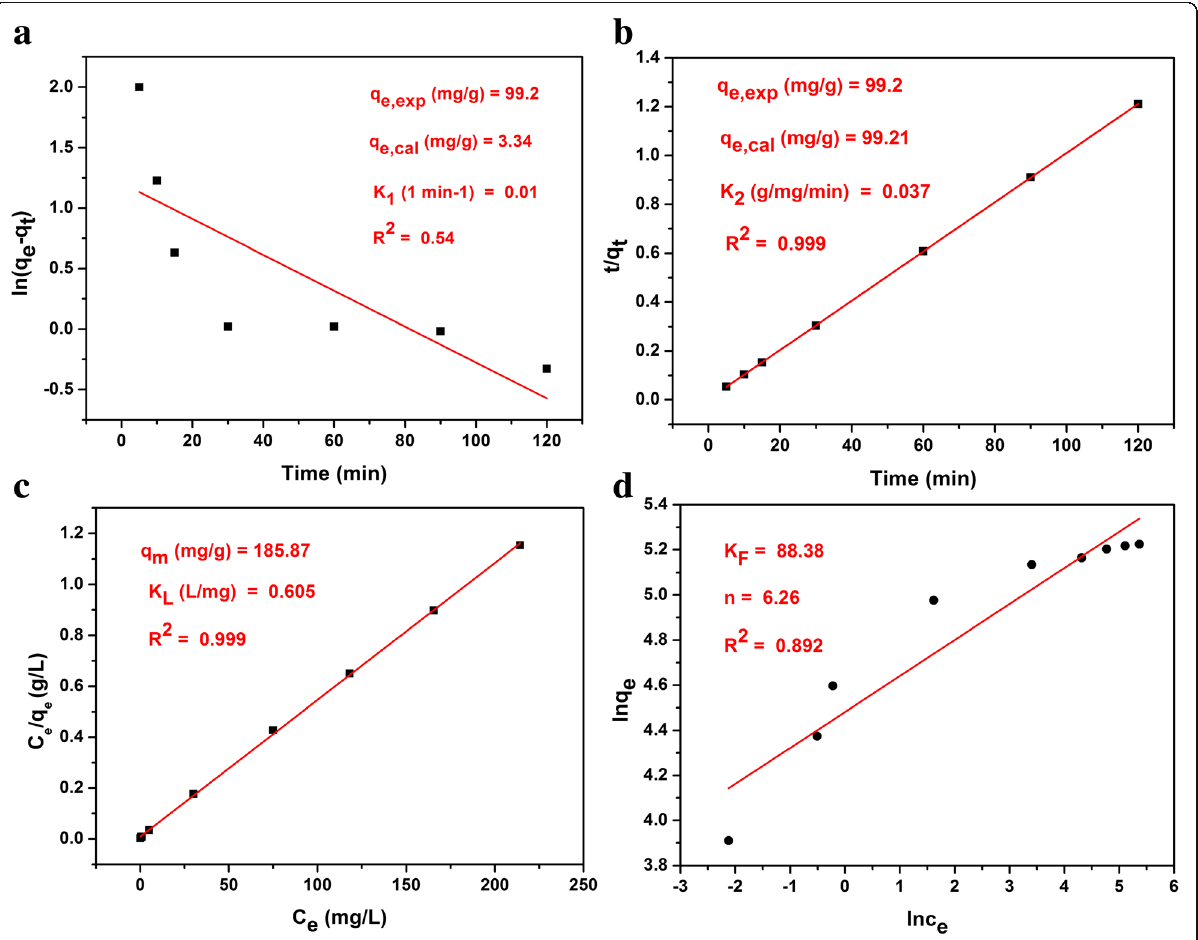
Fig. 5 a , b Pseudo-first-order and pseudo-second-order kinetic models for the adsorption of MB dye onto PS-Kaol, respectively. c , d Langmuir and Freundlich isotherm models for the adsorption of MB dye onto PS-Kaol,